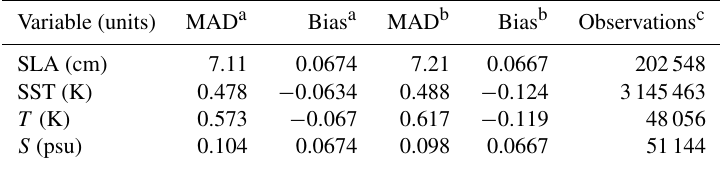
a One-day system. b Three-day